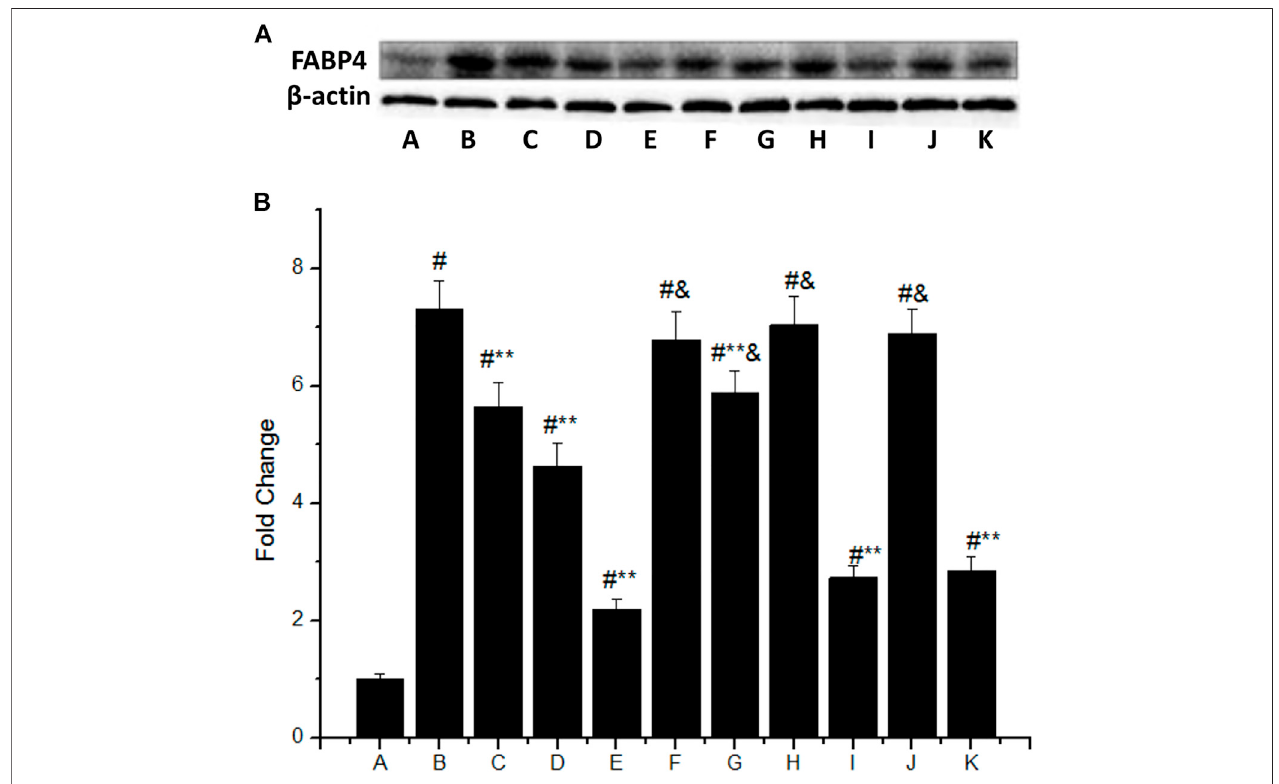
FIGURE3 | IMD inhibits FABP4 protein expression dose-dependently inox-LDL – stimulated macrophages partially through the PKA pathway. (A) Westernblot for FABP4 protein in RAW264.7; (B) Quantitative band density analysis according to the gray image scanning, and normalization of all bands to housekeeping protein β -actin. (A) control group; (B) ox-LDL group; (C) ox-LDL+20 nm IMD group; (D) ox-LDL+40 nm IMD group; (E) ox-LDL+80 nm IMD group; (F) ox-LDL + PKAI group; (G) ox-LDL + PKAI+80 nm IMD group; (H) ox-LDL + p38 inhibitor group; (I) ox-LDL + p38 inhibitor+80 nm IMD group; (J) ox-LDL + PKGI group; (K) ox-LDL + PKGI +80 nm IMD group. # Compared with group A ( p < 0.05); ** compared to group B ( p < 0.05); & compared to group E ( p <